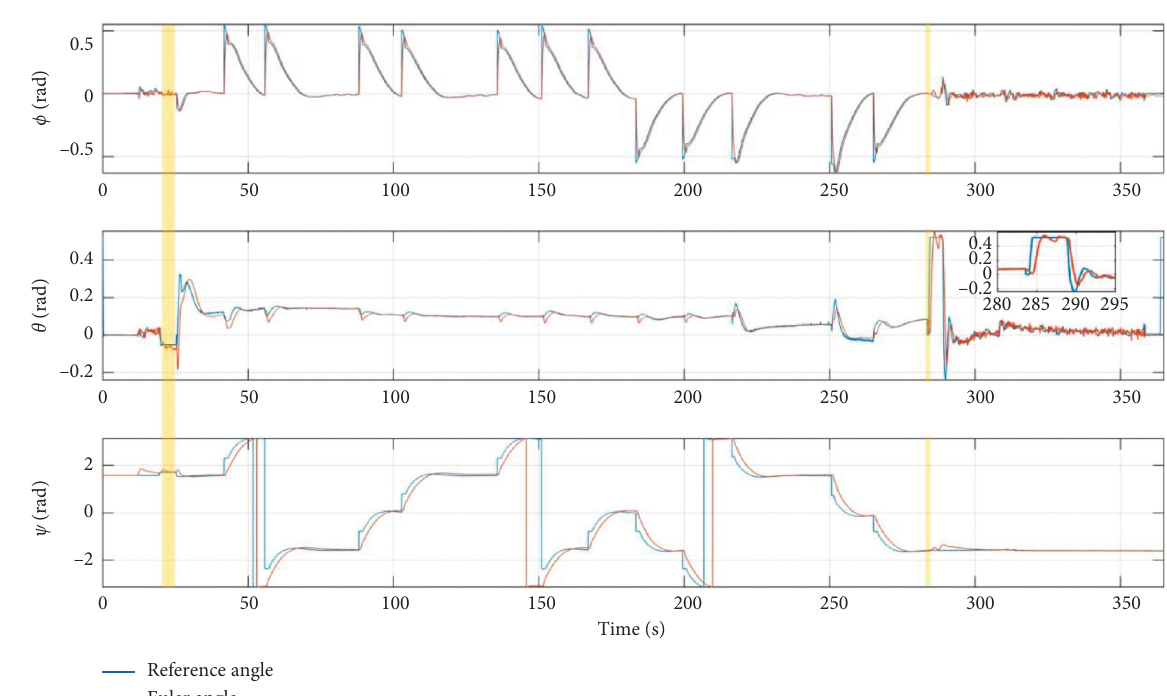
Figure 16: Attitude of the aircraft in HIL